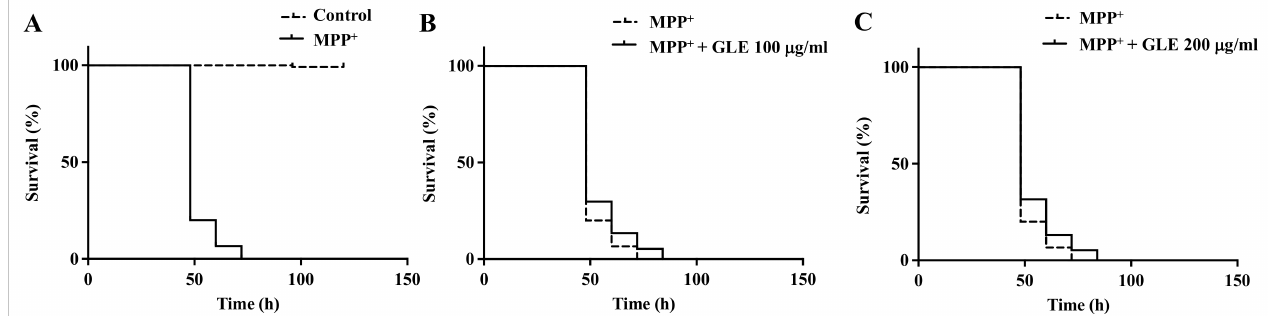
Figure 3. Effect of GLE on MPP + -induced neurotoxicity in daf-16 mutant C. elegans . ( A ) Lifespan curve of worms in the presence or absence of MPP + . ( B ) Lifespan curve of worms with MPP + -induced toxicity treated with 100 µ g/mL GLE. ( C ) Lifespan curve of worms with MPP + -induced toxicity treated with 200 µ g/mL GLE. Each experiment was repeated independently at least thrice, and one of the representative data is shown.